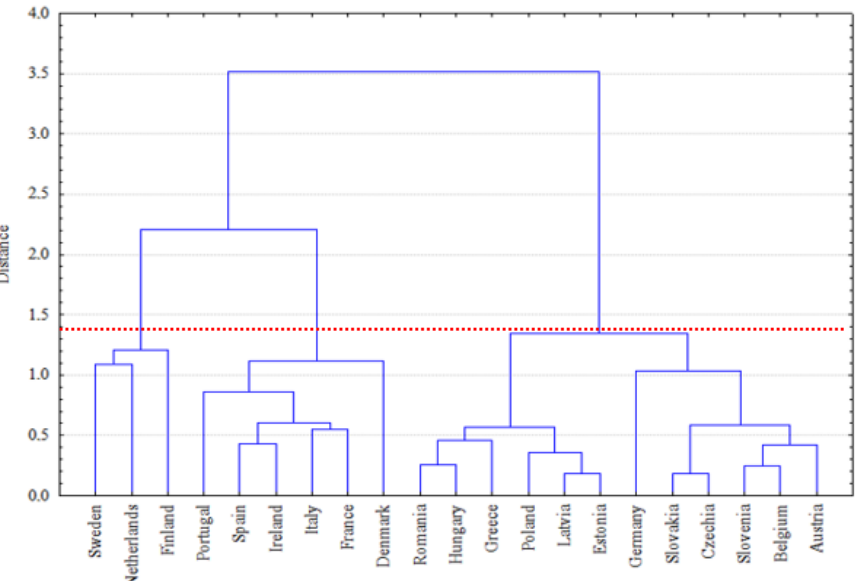
Figure 4. The dendrogram of hierarchical clustering using Ward’s method for selected countries from EU. Source: own study.